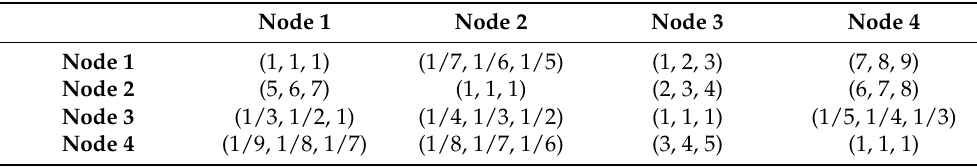
Table A4. Pairwise comparison matrix for distance criterion as TFN.